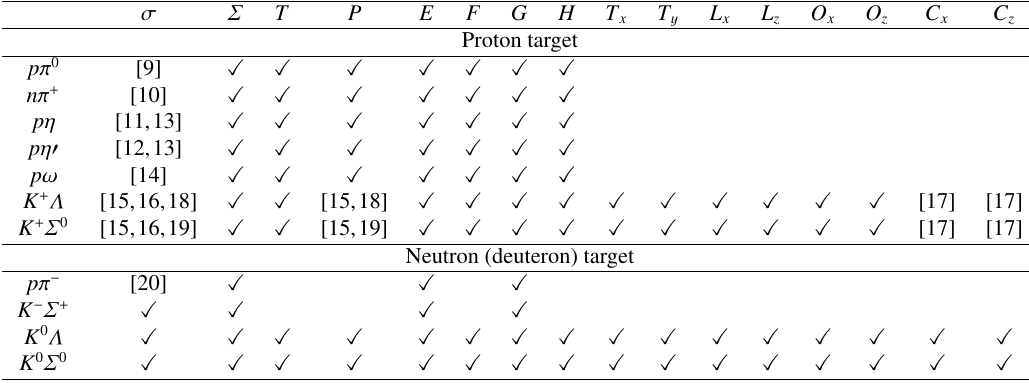
Table 1. Observables in single pseudo-scalar meson photoproduction. ” (cid:88) ” indicates data already accumulated and being